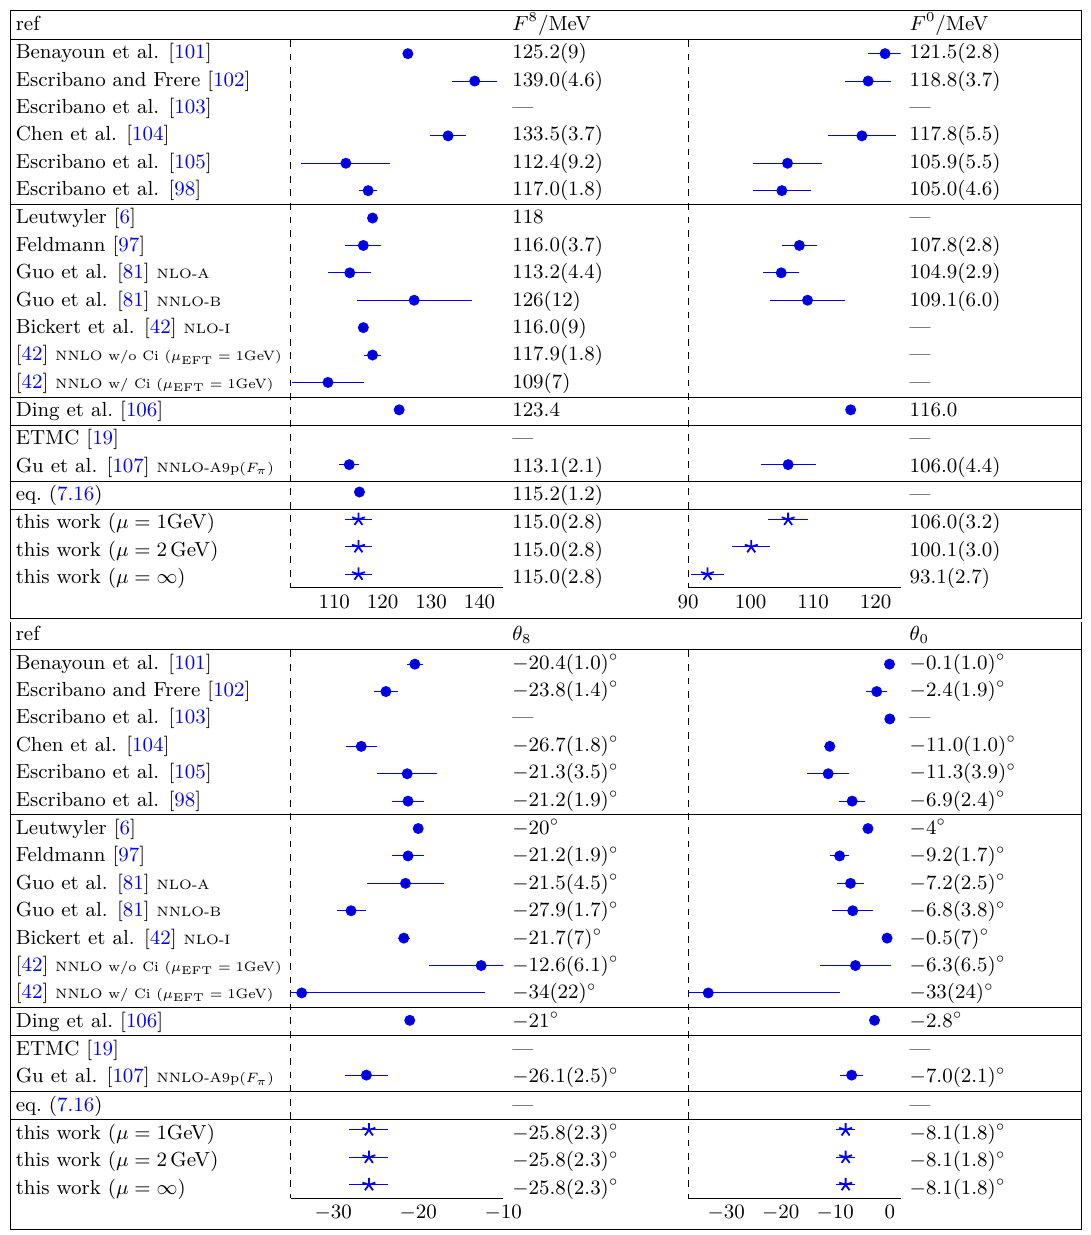
Table 17. Comparison of recent phenomenological and lattice results for the decay constants in the angle representation for the octet/singlet basis, where only F 0 depends on the scale. We use F . 1 MeV [63] to convert decay constants given as a multiple of F π and eq. (7.16) refers π + = 92 to the NLO result from literature pion and kaon decay constants. The results from this work are presented at three different